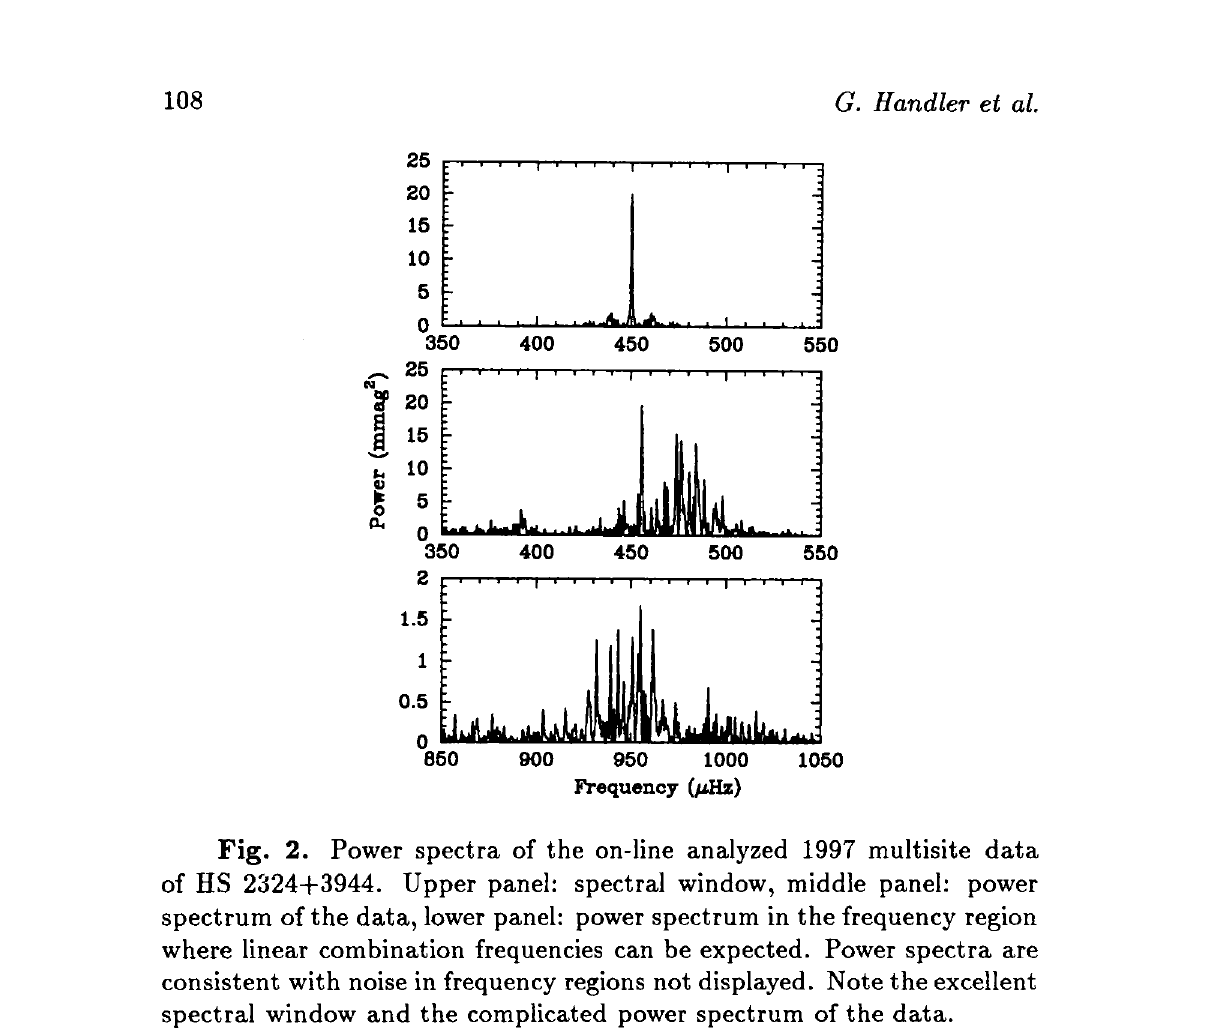
Fig. 2. Power spectra of the on-line analyzed 1997 multisite data of HS 2324+3944. Upper panel: spectral window, middle panel: power spectrum of the data, lower panel: power spectrum in the frequency region where linear combination frequencies can be expected. Power spectra are consistent with noise in frequency regions not displayed. Note the excellent spectral window and the complicated power spectrum of the